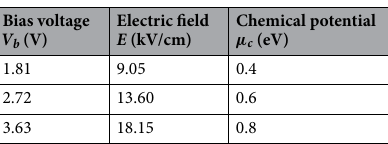
Table 3. Bias voltage and corresponding chemical potential of graphene for the proposed antenna.